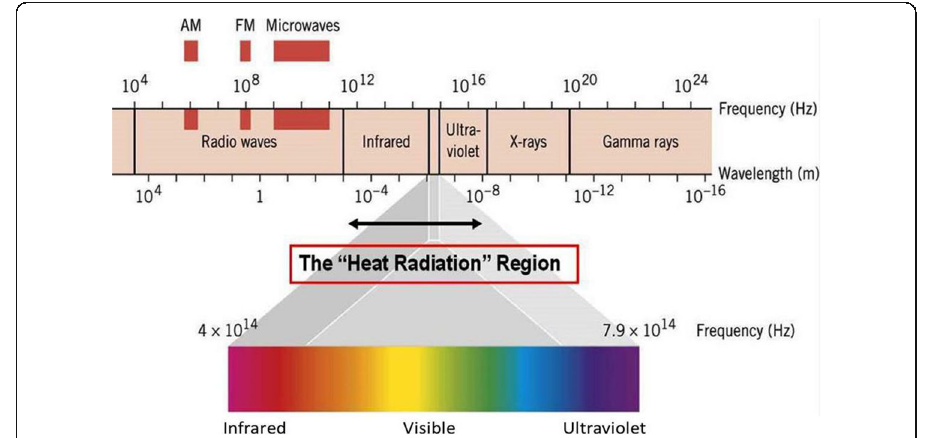
Fig. 12 Spectrum of thermal radiation in hypersonic